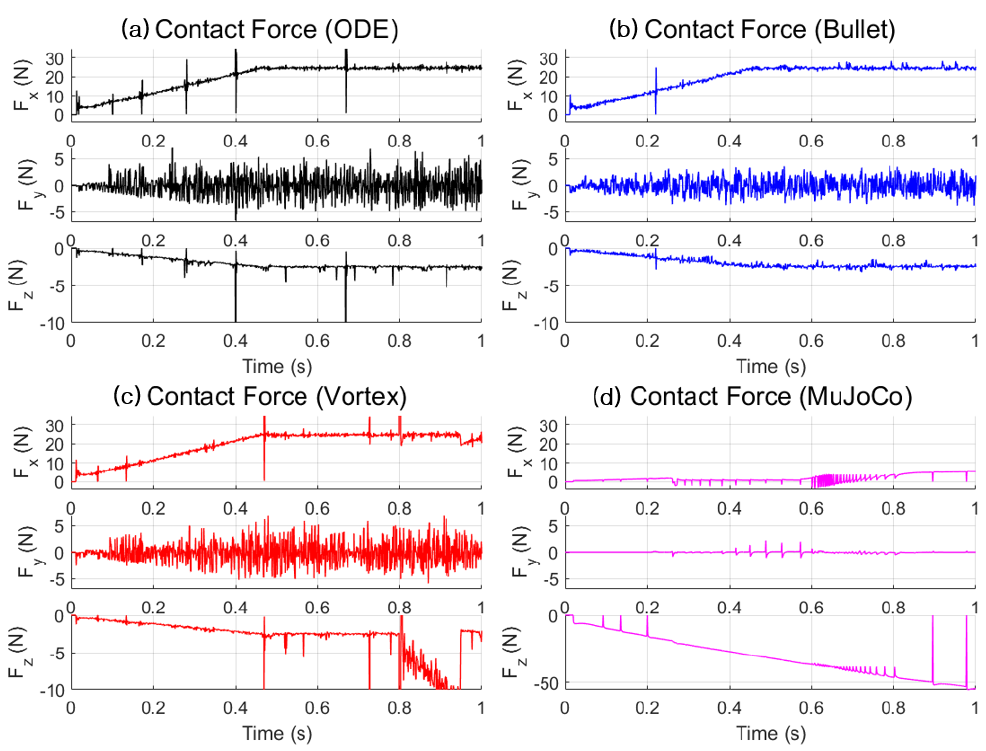
Figure 8. Contact force acting on the peg of each physics engine for peg-in-hole scenario: ( a ) ODE;